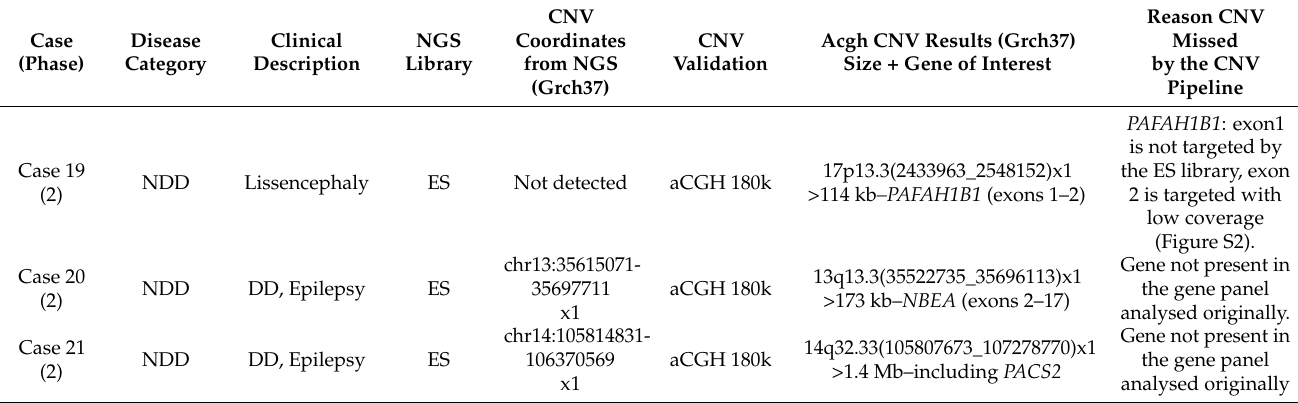
Table 2. List of cases with CNVs not detected by the NGS-based CNV